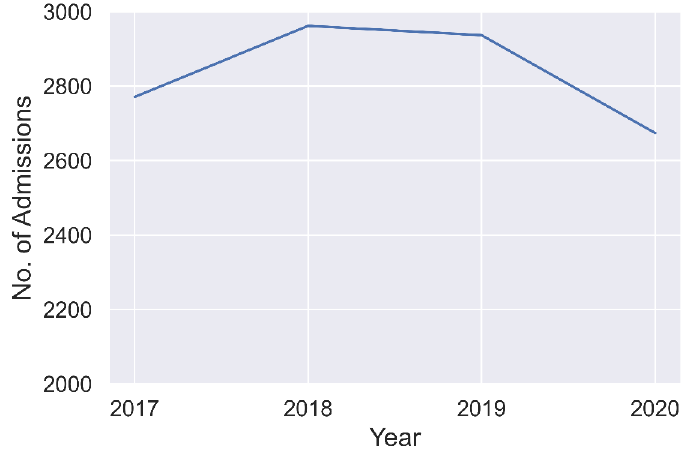
Figure 2. The yearly trend in the number of asthma